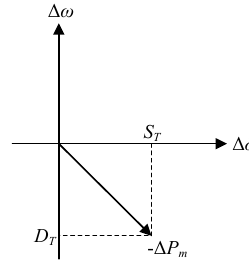
Figure 2. The position of mechanical torque.